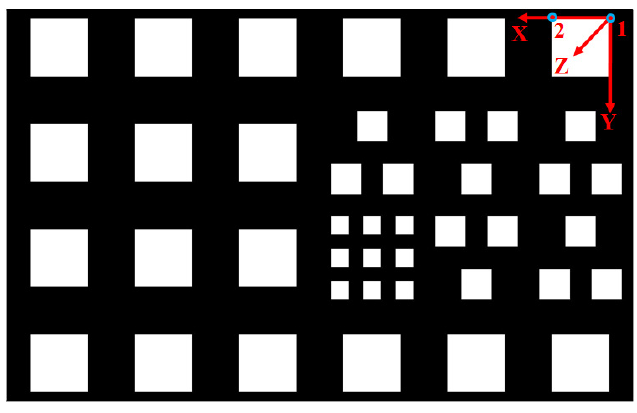
Figure 4. The self-calibration target field.